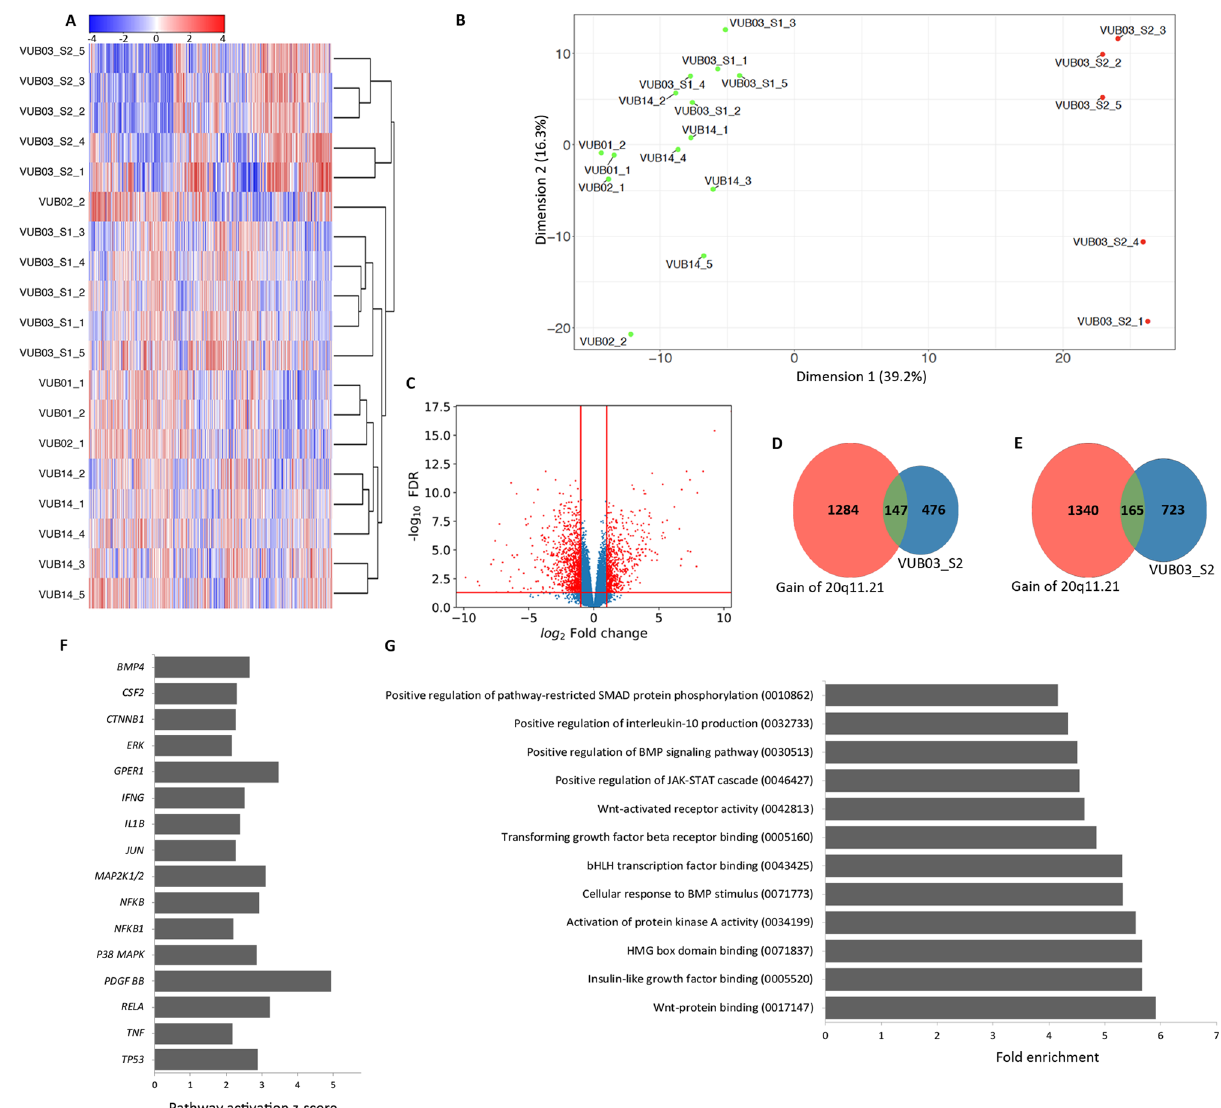
Figure 2. VUB03_S2 shows a unique transcriptomic signature characterized by WNT and BMP4 signalling deregulation. ( A ) Unsupervised cluster analysis and ( B ) Principal component analysis of component 1 versus component 2 of all coding genes with a count per million greater than one in at least two samples. ( C ) Volcano plot of the differential gene expression analysis of VU03_S2 versus all other hESC lines. The red lines show cut-off values of |log 2 Fold Change|> 1 and FDR < 0.05. ( D , E ) Venn diagrams comparing the deregulated genes in VUB03_S2 with those deregulated in lines with a 20q11.21 gain. ( D ) Shows the upregulated genes and ( E ) the downregulated genes ( A – E ) 35 . ( F ) Ingenuity pathway analysis of all differentially expressed genes with |log 2 Fold Change|> 1 and FDR < 0.05. The plot shows only upstream regulators of pathways with an activation score below -2 and above 2 with a p < 0.05. ( G ) DAVID Enrichment Analysis of the 1000 top-deregulated genes, showing only gene-ontology terms related to intracellular signalling (full list in supplementary table S2). In parenthesis are the gene-ontology term